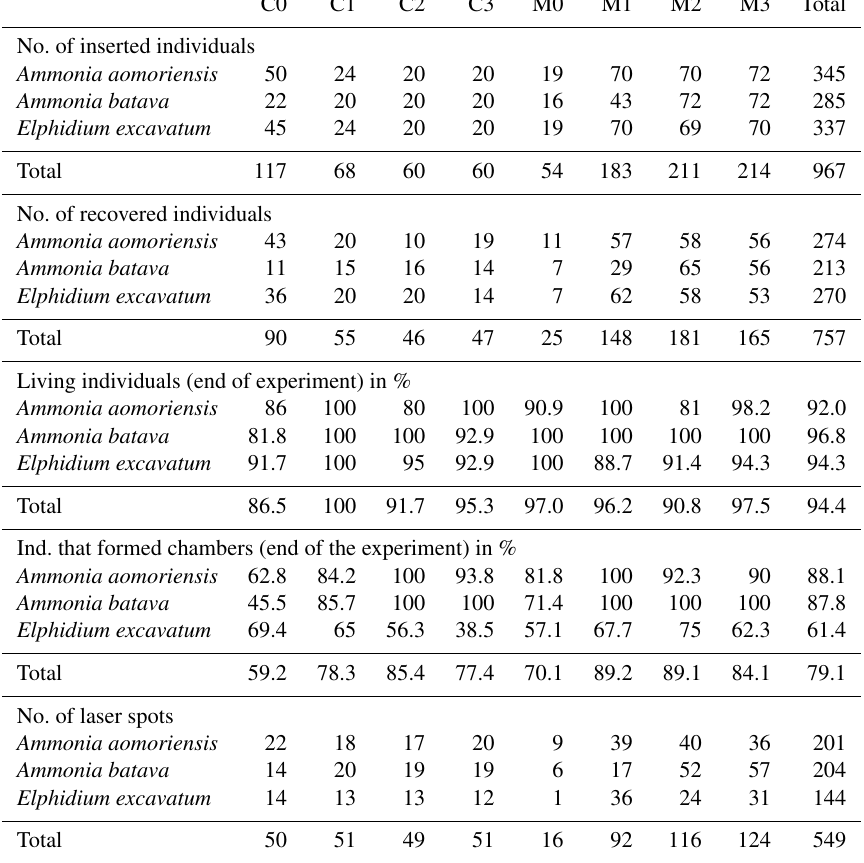
Table 2. Number of inserted and recovered foraminifera from the different systems (C is control system; M is metal system) and phases (0–3). Numbers of living individuals after the experiment and individuals that formed chambers during their individual culturing phase are given in percent. Note that the percentage of living foraminifera is based on the number of foraminifera that could be recovered alive and not on the number of inserted individuals. The number of laser spots is indicated as